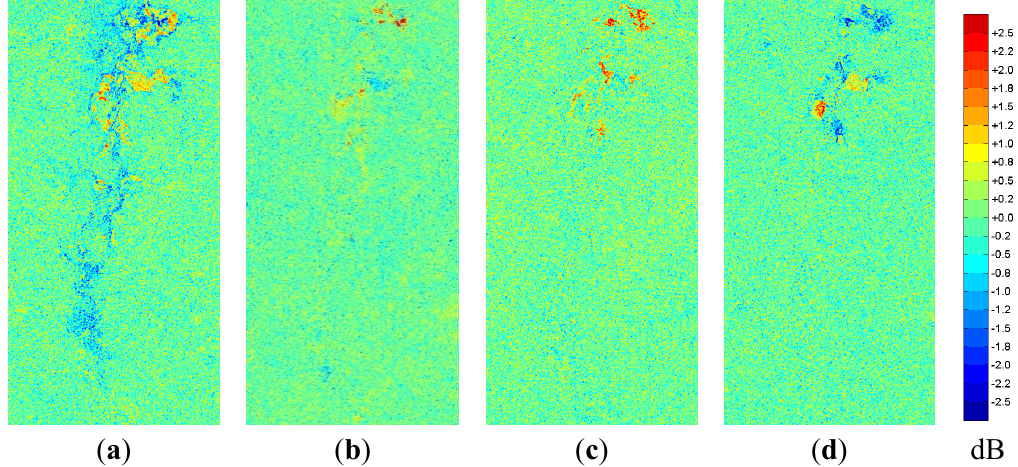
Figure 14. Change in Kennaugh Element k acquisitions scaled in decibel: ( a ) April to May; ( b ) May to June; ( c ) June to July; and ( d ) July to August.